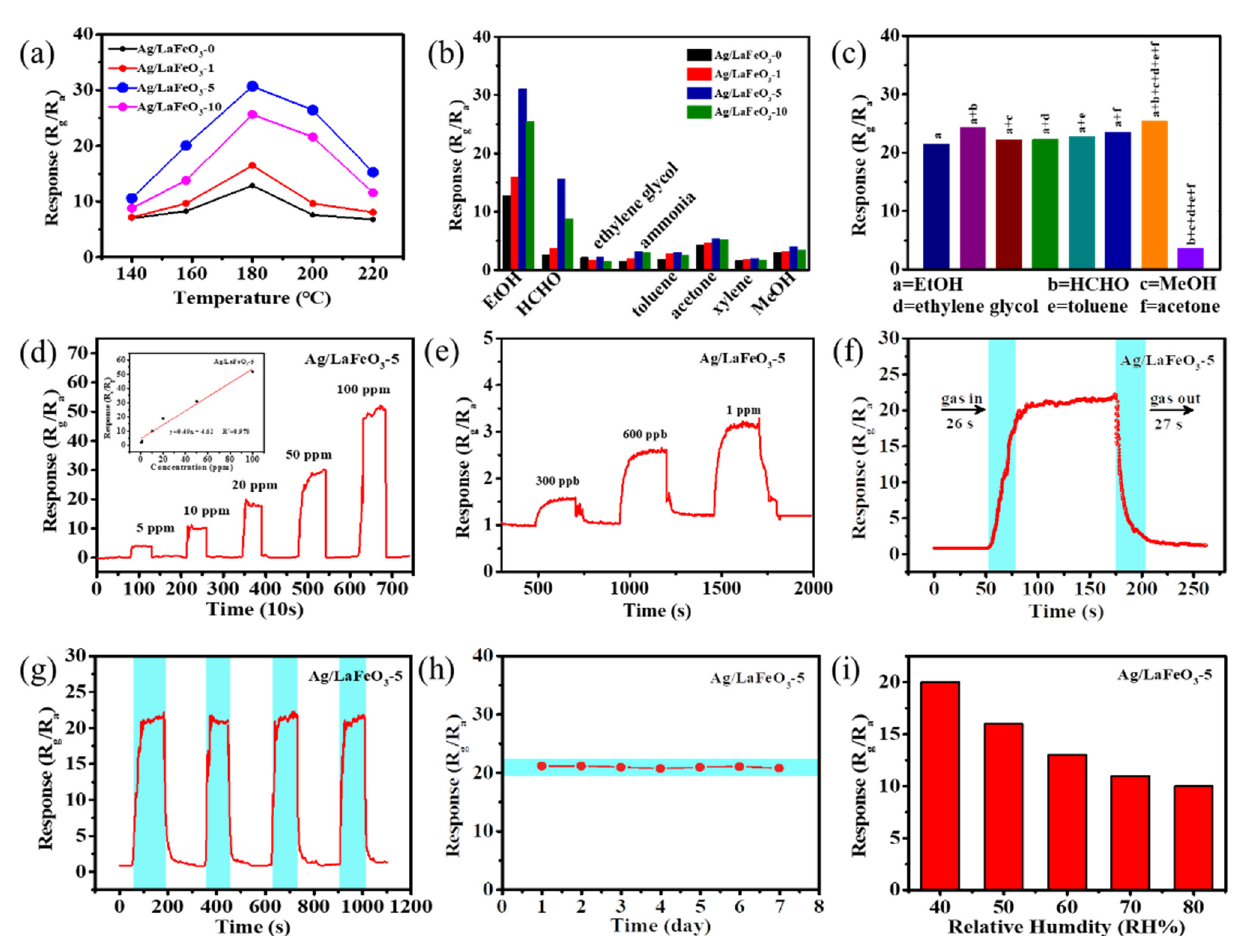
Figure 5. ( a ) The response of Ag/LaFeO 3 − 0--Ag/LaFeO 3 − 5 nanomaterials to 50 ppm ethanol in the range of 140–220 °C; ( b ) selectivity of the four Ag/LaFeO 3 sensors for different gases at 180 °C (concentrations of 50 ppm for all gas); ( c ) sensor response values for Ag/LaFeO 3 − 5 at 180 °C for a mixture of vapors (20 ppm concentration of these gases); ( d ) response curves of the Ag/LaFeO 3 − 5 sensor for EtOH vapors ranging from 5 ppm to 100 ppm concentration, the inset exhibits a direct linearity correlation between the sensing response values and EtOH vapor levels; ( e ) dynamic response curve of Ag/LaFeO 3 − 5-based sensors under a low concentration of EtOH exposed at 180 °C; ( f ) sensing curves and ( g ) reproducibility of the Ag/LaFeO 3 − 5 sensor for 20 ppm EtOH vapors; ( h ) the long-term stability of sensitive materials; ( i ) response of Ag/LaFeO 3 − 5-based sensors to 20 ppm EtOH under different RH%.